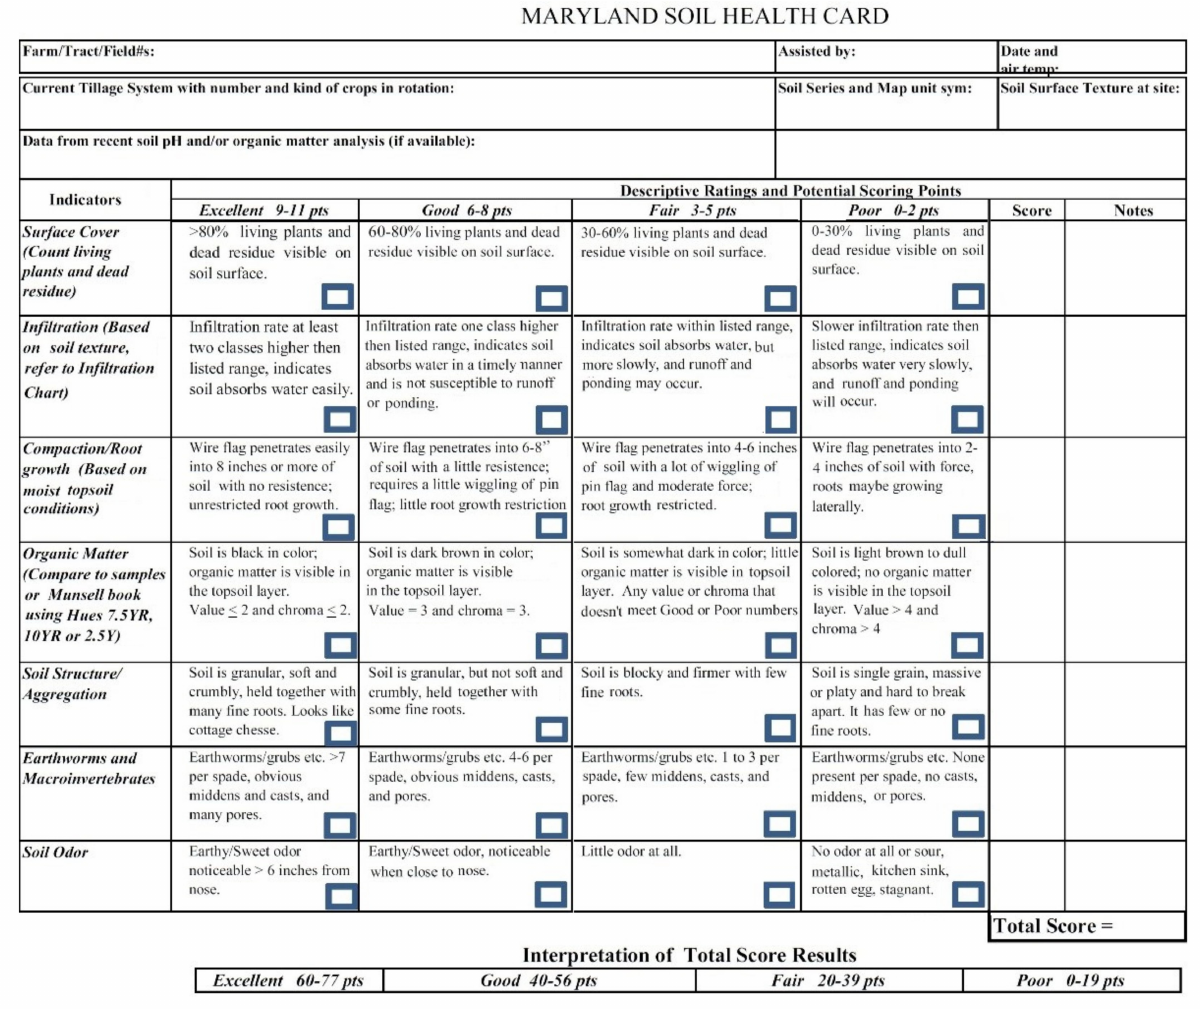
Figure 3. Maryland Soil Health Card showing individual soil health indicators and the associated descriptive ratings